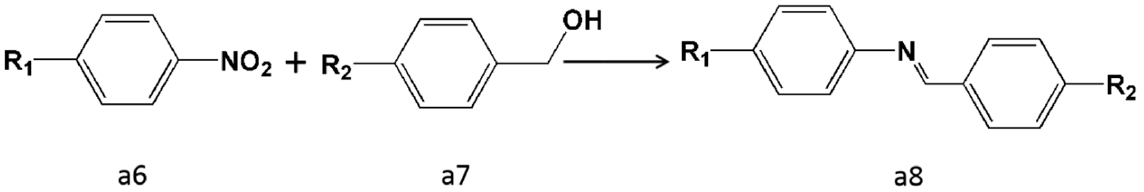
Figure 6. Photocatalytic One-Pot Synthesis of Imine from Nitroaromatics and Aromatic Alcohols. Table 3. The photocatalytic synthesis of Imine from several other substrates over the Co 0.6 Ni 0.4 S 2 /rGO catalyst.